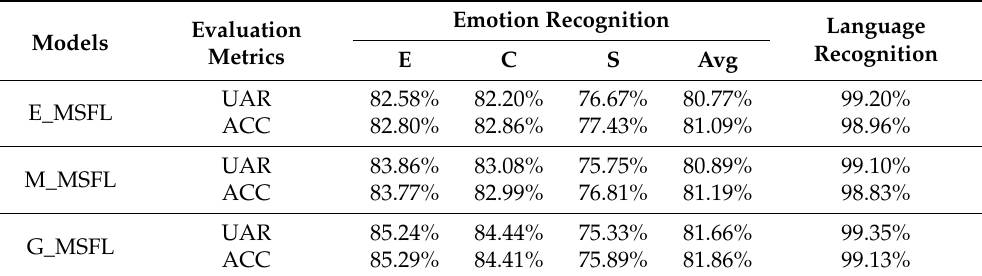
Table 5. Experimental performance comparison of MSFL models with different weight adjustment methods.